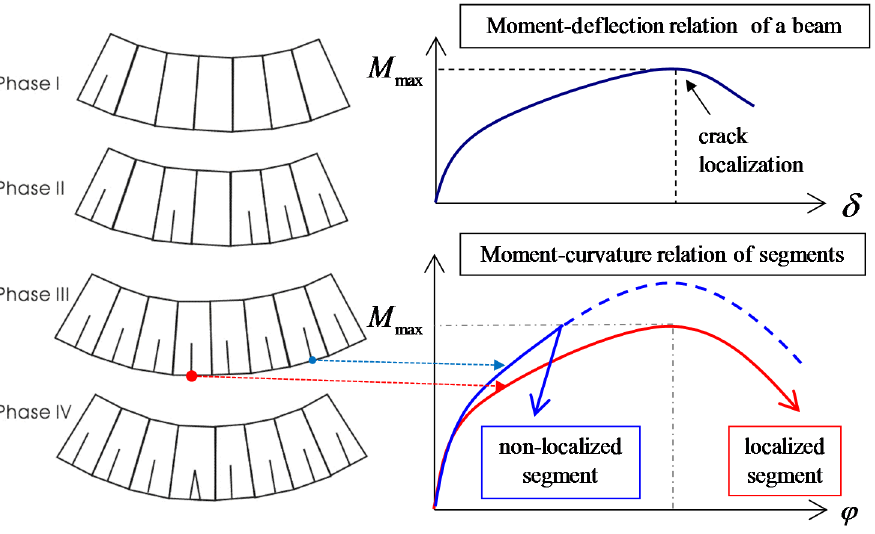
Figure 9. Deflection of a beam and curvature of segments.